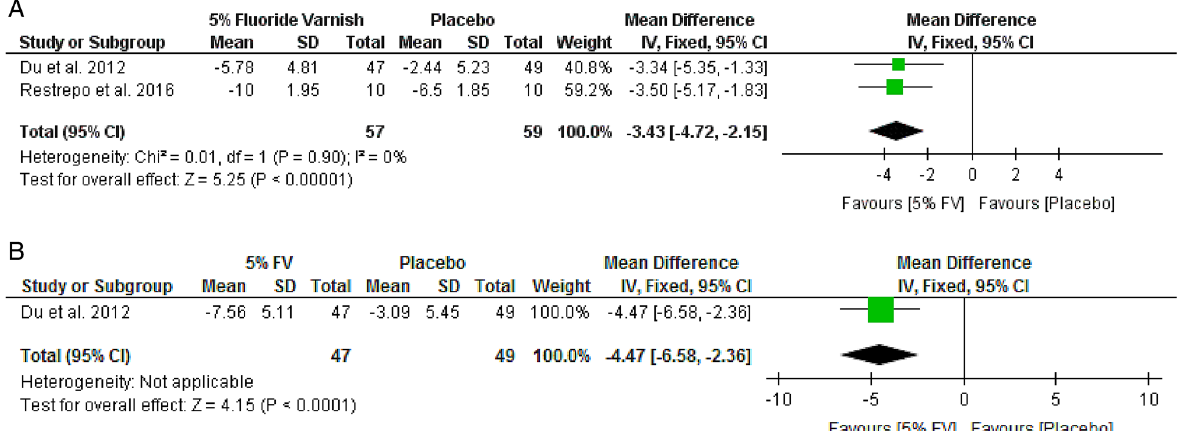
Figure 3. Forest-plot presenting the effect of FV applications on the mean DIAGNOdent scores of white-spot lesions occurring after orthodontic treatment at 3 months (A) and at 6 months